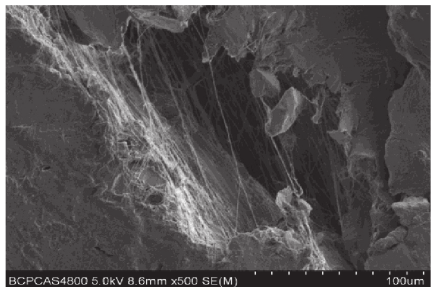
Figure 11: SEM micrograph of the fractures in the PTFE matrix.